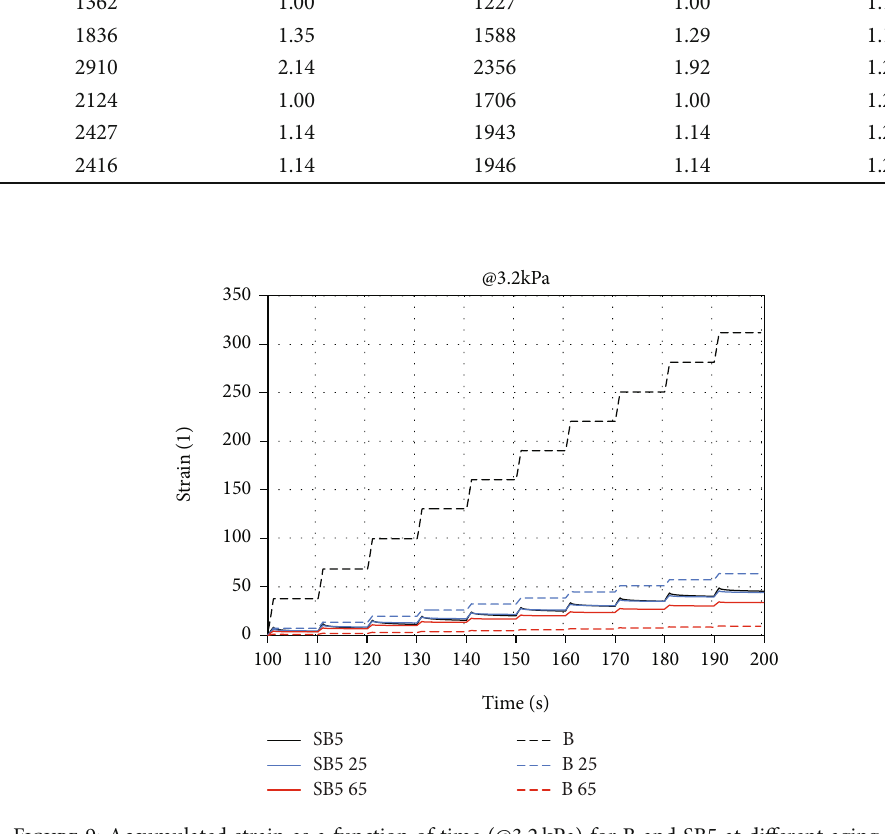
Figure 9: Accumulated strain as a function of time (@3.2kPa) for B and SB5 at di ff erent aging levels.